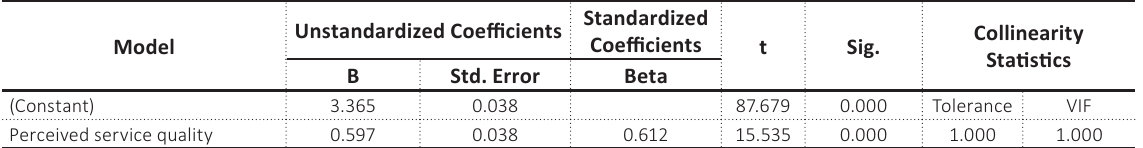
Table 6. Regression results (perceived service quality and price perception)